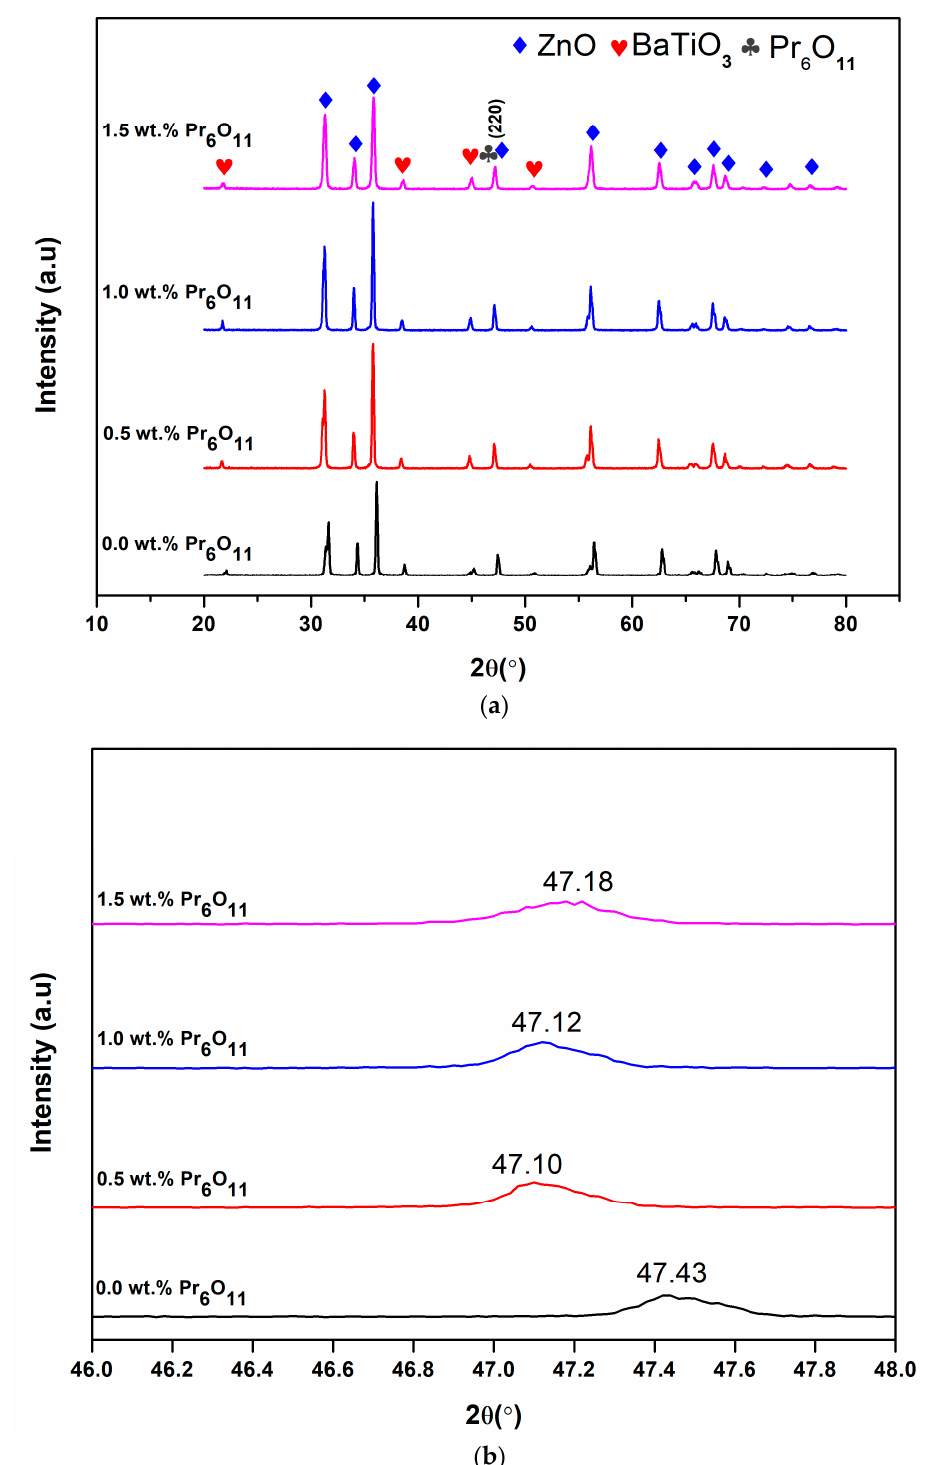
Figure 2. The XRD spectra of ZnO-BaTiO 3 based varistor doped with different amounts of Pr 6 O 11 ( a ) XRD patterns of Pr 6 O 11 -doped ZnO-BaTiO 3 varistor ceramics and ( b ) XRD patterns of (220) diffraction.